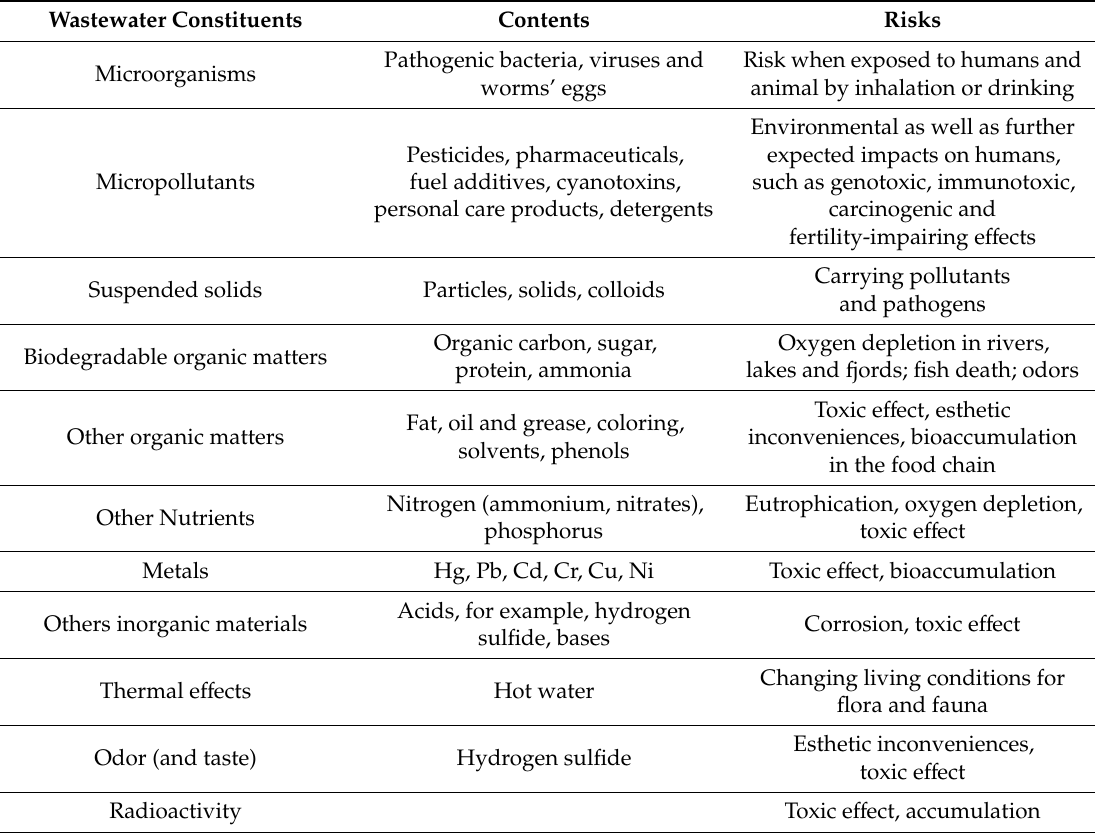
Table 3. Constituents present in wastewater with their associated risks